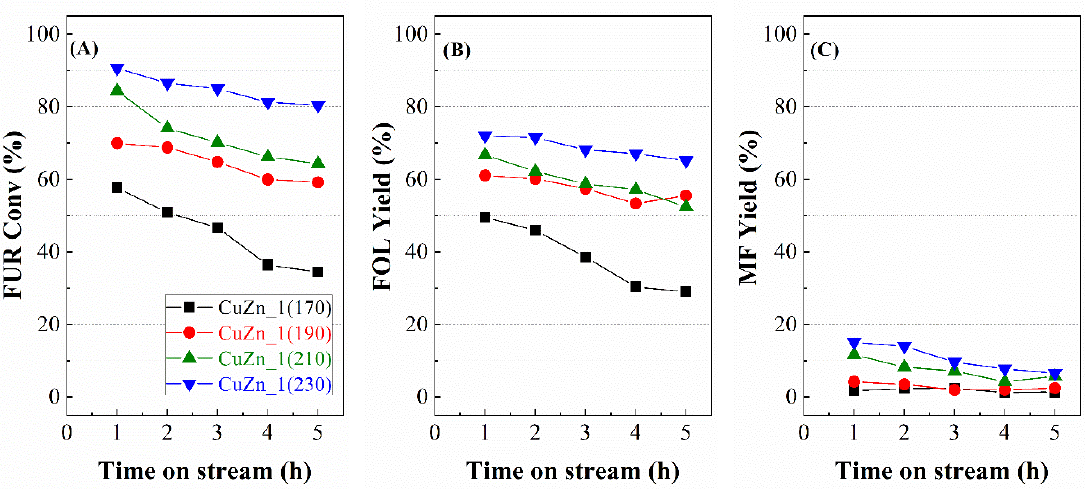
Figure 11. FUR conversion ( A ), FOL yield ( B ), and MF yield ( C ) in the FUR hydrogenation with CuZn_6 (Experimental conditions: Mass of catalyst = 0.15 g, Pressure = 0.1 MPa, H 2 flow = 10 mL min − 1 , Fed flow = 2.3 mmol FUR h − 1 ).